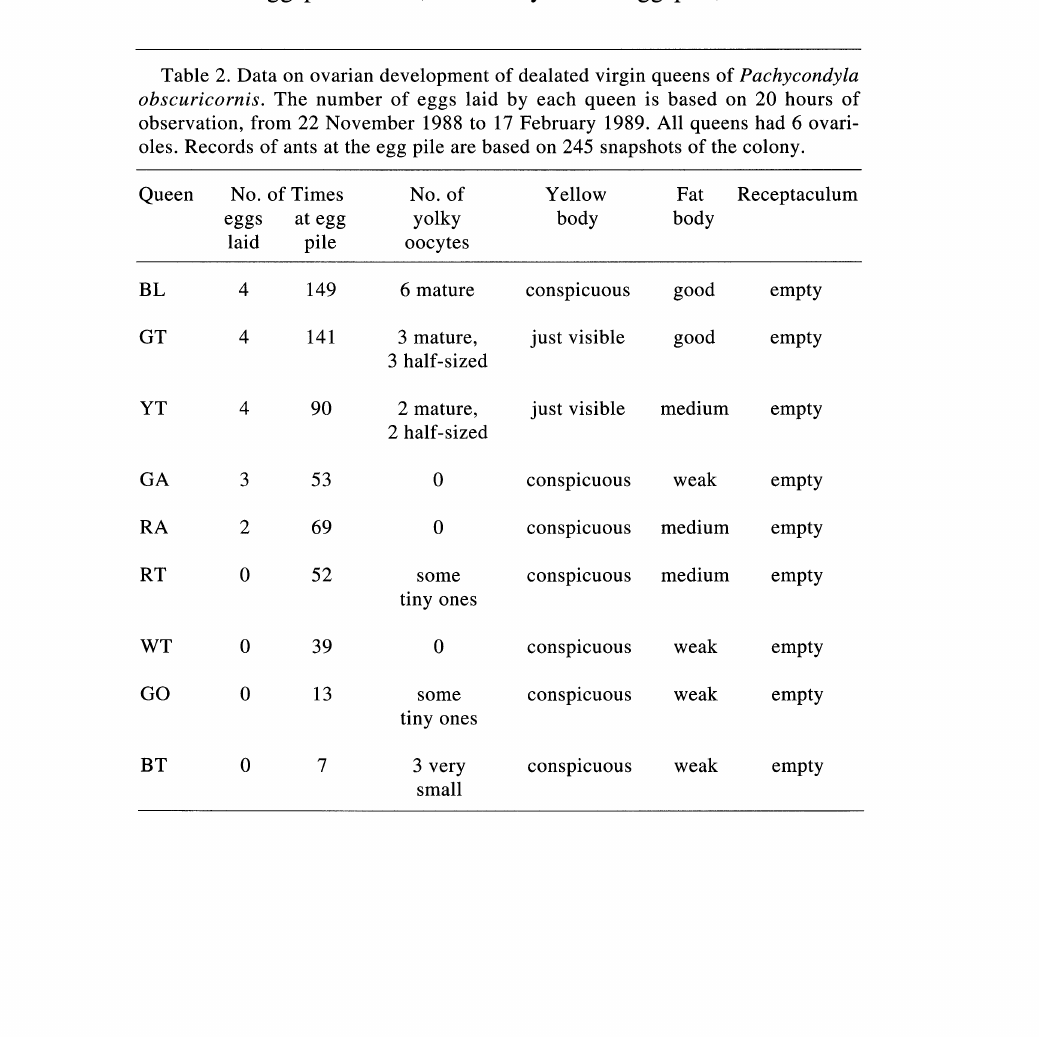
No. of Yellow Fat Receptaculum eggs body body